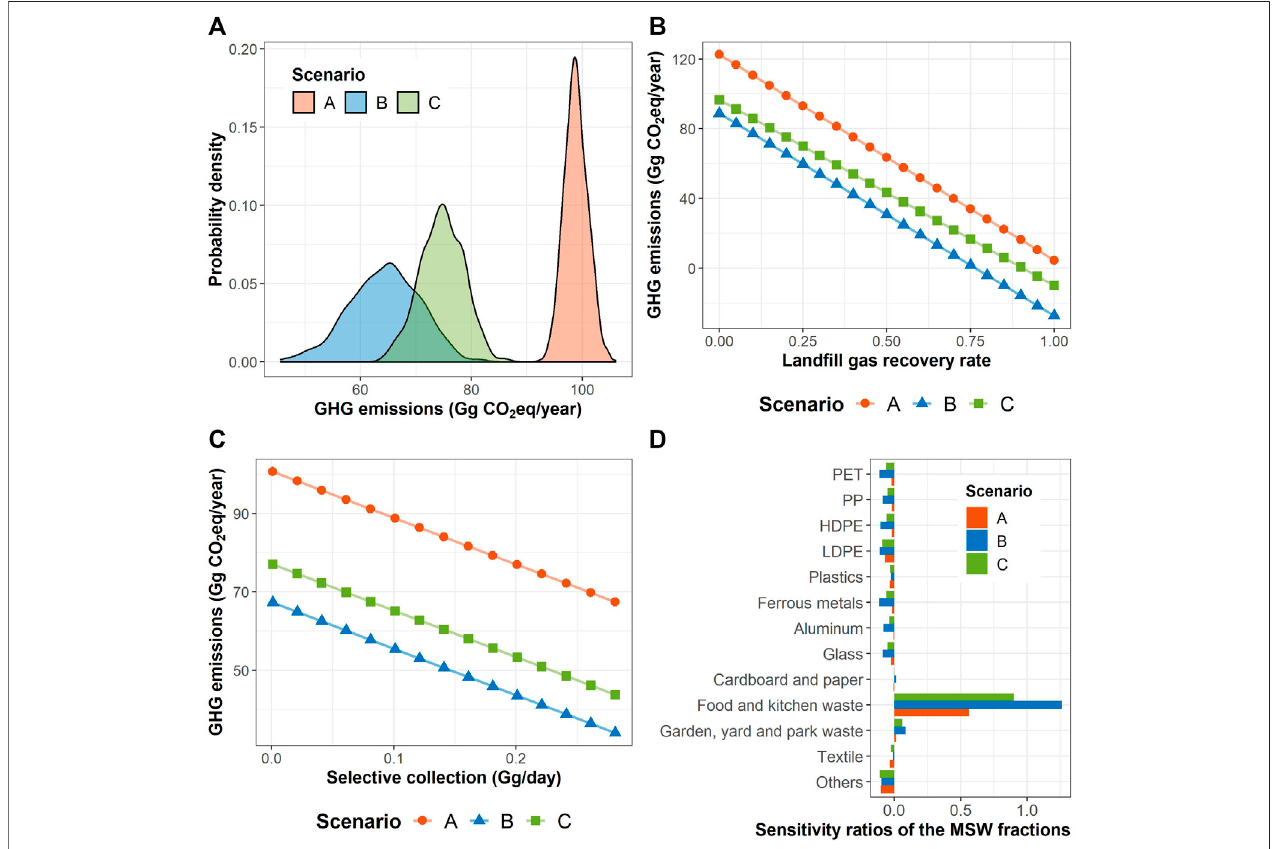
FIGURE 6 | Sensitivity analysis of key parameters and their impact on the net GHGs emissions and scenario performance: (A) MSW composition; (B) Land fi ll gas recovery fraction; (C) Selective collection; (D) Perturbation analysis of MSW fractions.